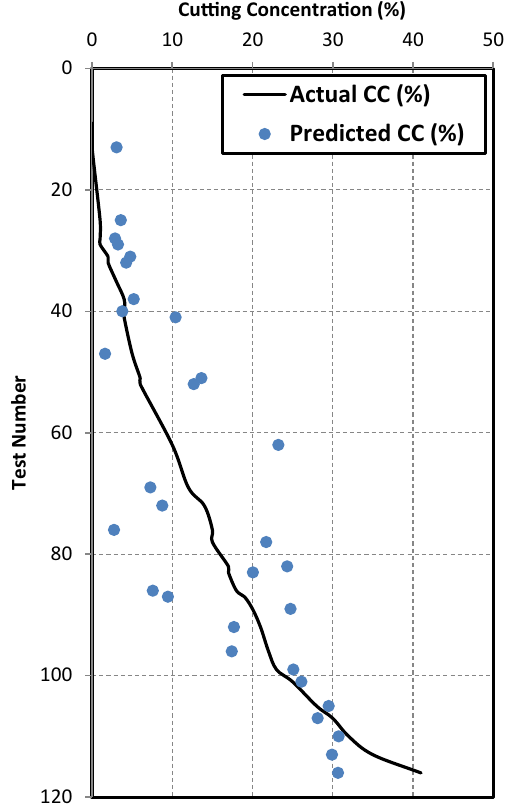
Fig. 6 Actual (experimental) and BPNN-predicted cutting concentra- tion versus test number from network testing